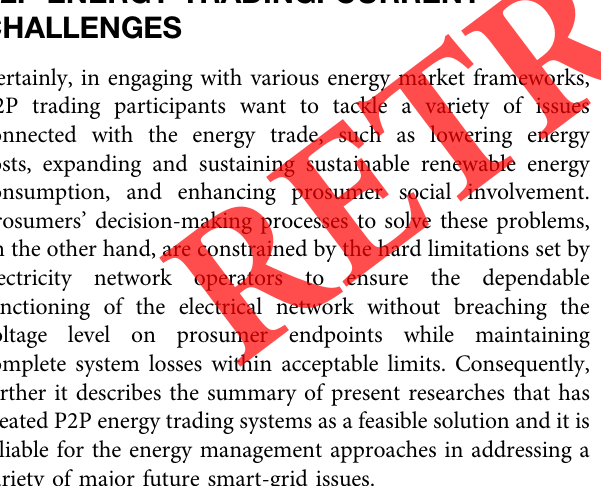
Frontiers in Energy Research |